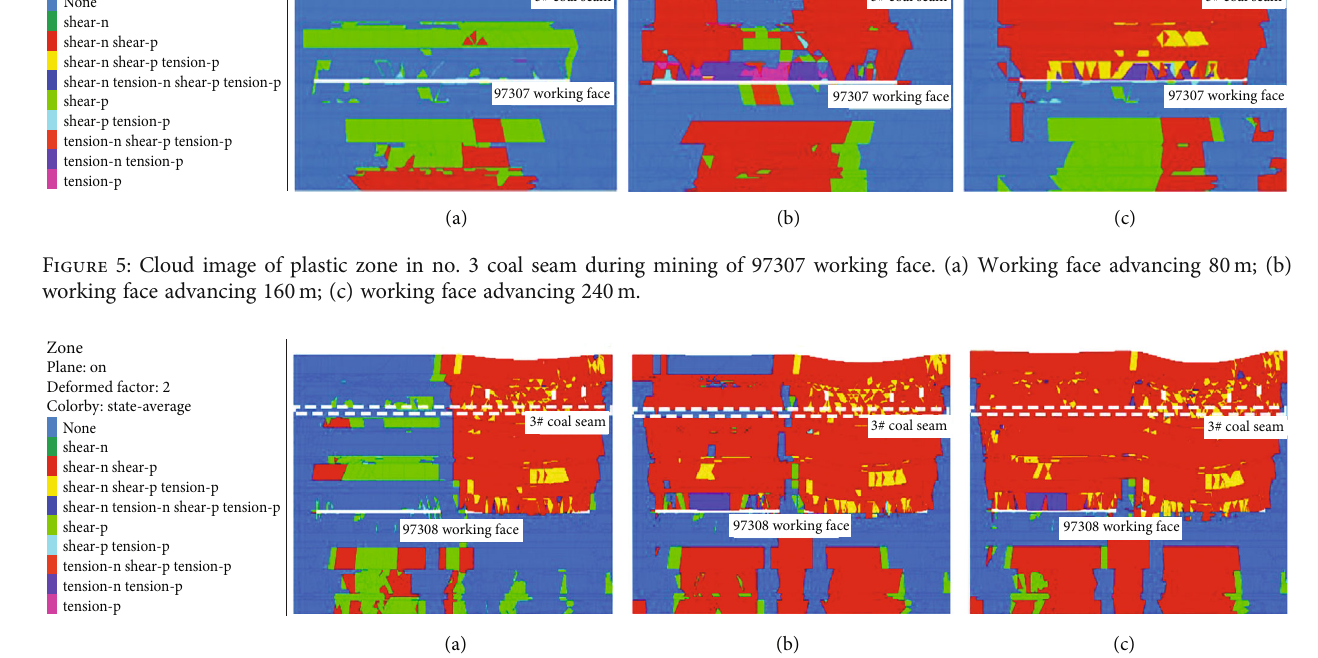
Figure 6: Cloud image of plastic zone in no. 3 coal seam during mining of 97308 working face. (a) Working face advancing 80m; (b) working face advancing 160m; (c) working face advancing 240m.